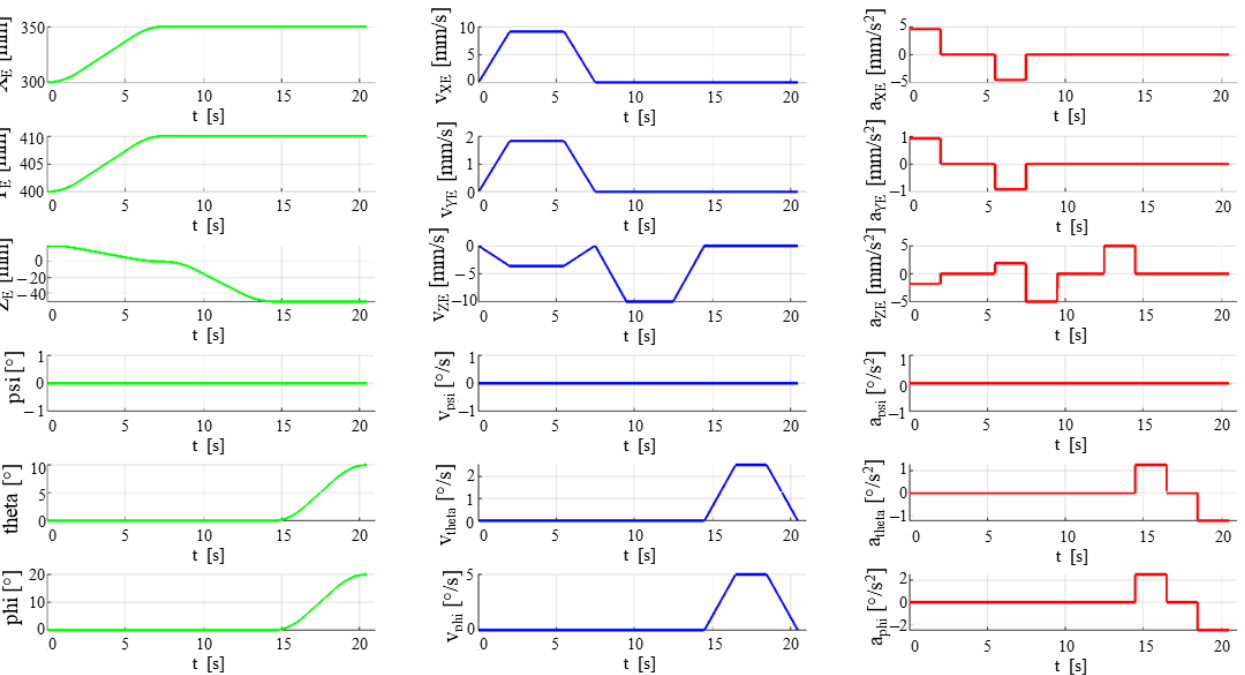
Figure 23. Time history diagrams of the input trajectory (position — green, velocity — blue, accelera- tions — red).